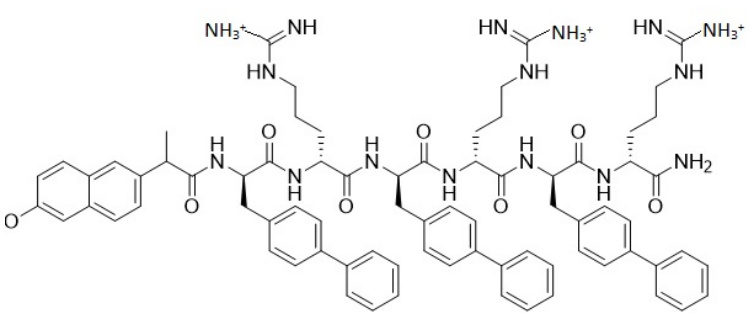
Figure 1. The chemical structure of alapropoginine at physiological pH.